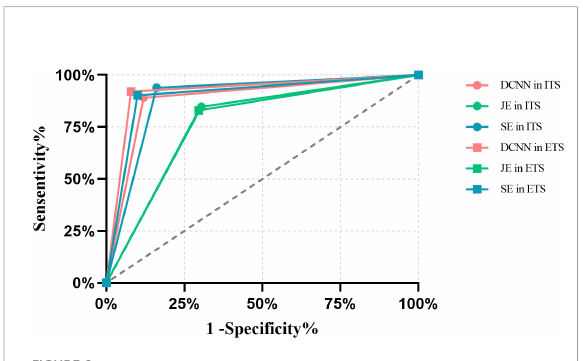
FIGURE 2 ROC curve of DCNN model and endoscopists in internal test sets and external test